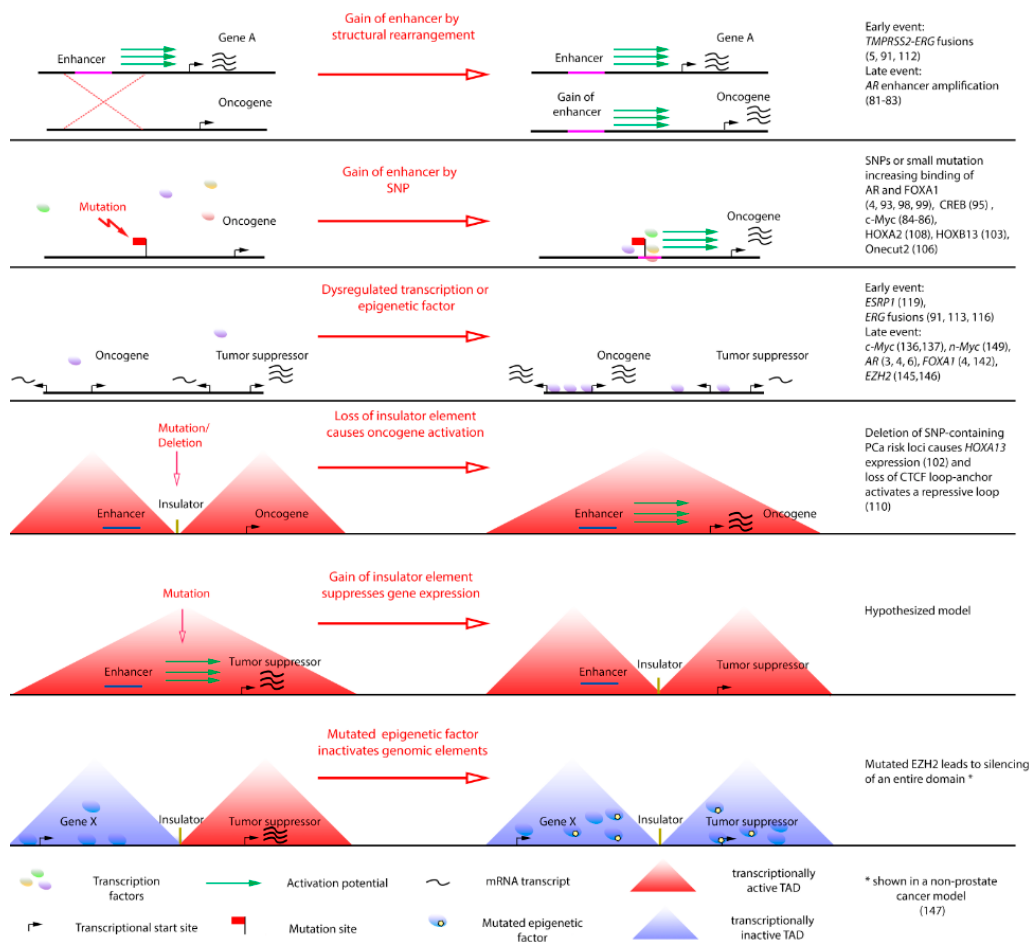
Figure 2. Events disrupting gene regulatory elements or TADs lead to oncogenic transcriptional dysregulation. The normal cell state (left side) is dysregulated by an oncogenic event which leads to a malignant cell state (right side). TADs comprise insulated genomic regions which can be transcriptionally active (red triangles) or inactive (blue triangles). Examples and selected references for each event are given in the right-hand column, with a focus on prostate cancer.